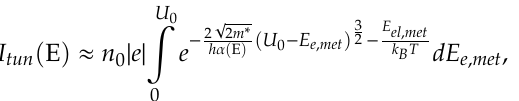
BNNS thicknesses.